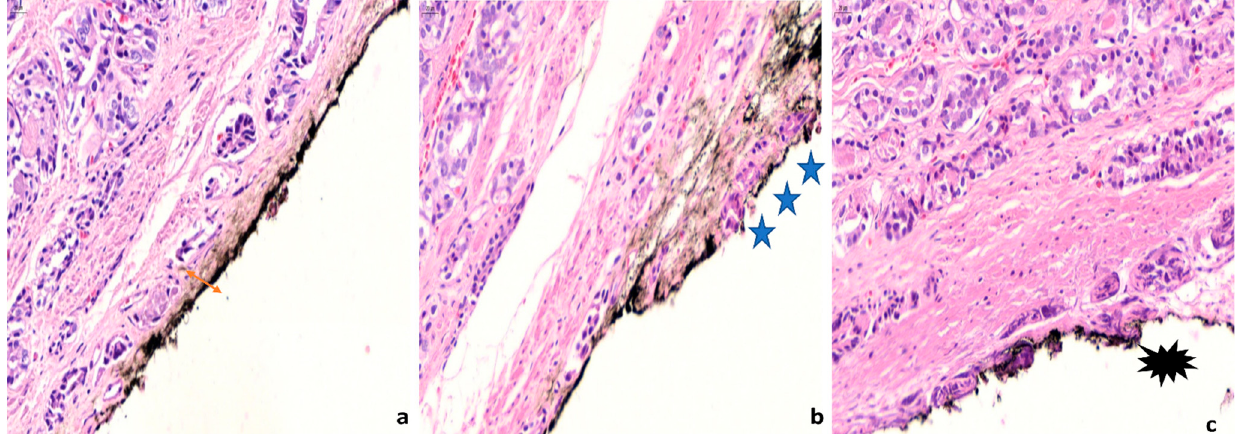
Figure 2. Definition of margin positivity ( a ) Neoplastic cells are close but not in contact with the ink. The distance between the inked margin and the neoplastic cells is pointed with a double-sided arrow. ( b ) Neoplastic cells are in contact with the ink. This is considered a positive margin. Three asterisks indicate the area of margin infiltration. ( c ) Cautery artifact in neoplastic cells in contact with the ink. An asterisk highlights the area of cautery effect. (400× magnification) .